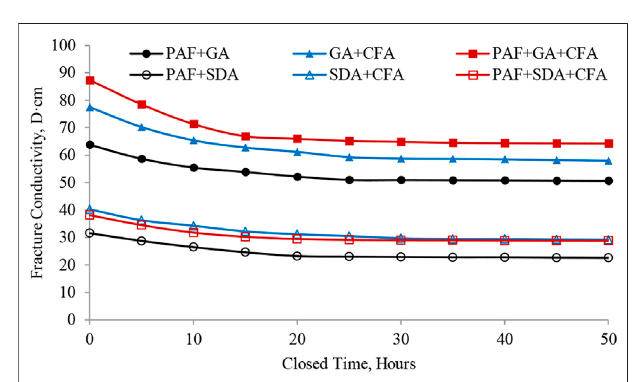
FIGURE 7 | Effect of main acid type on fracture conductivity.